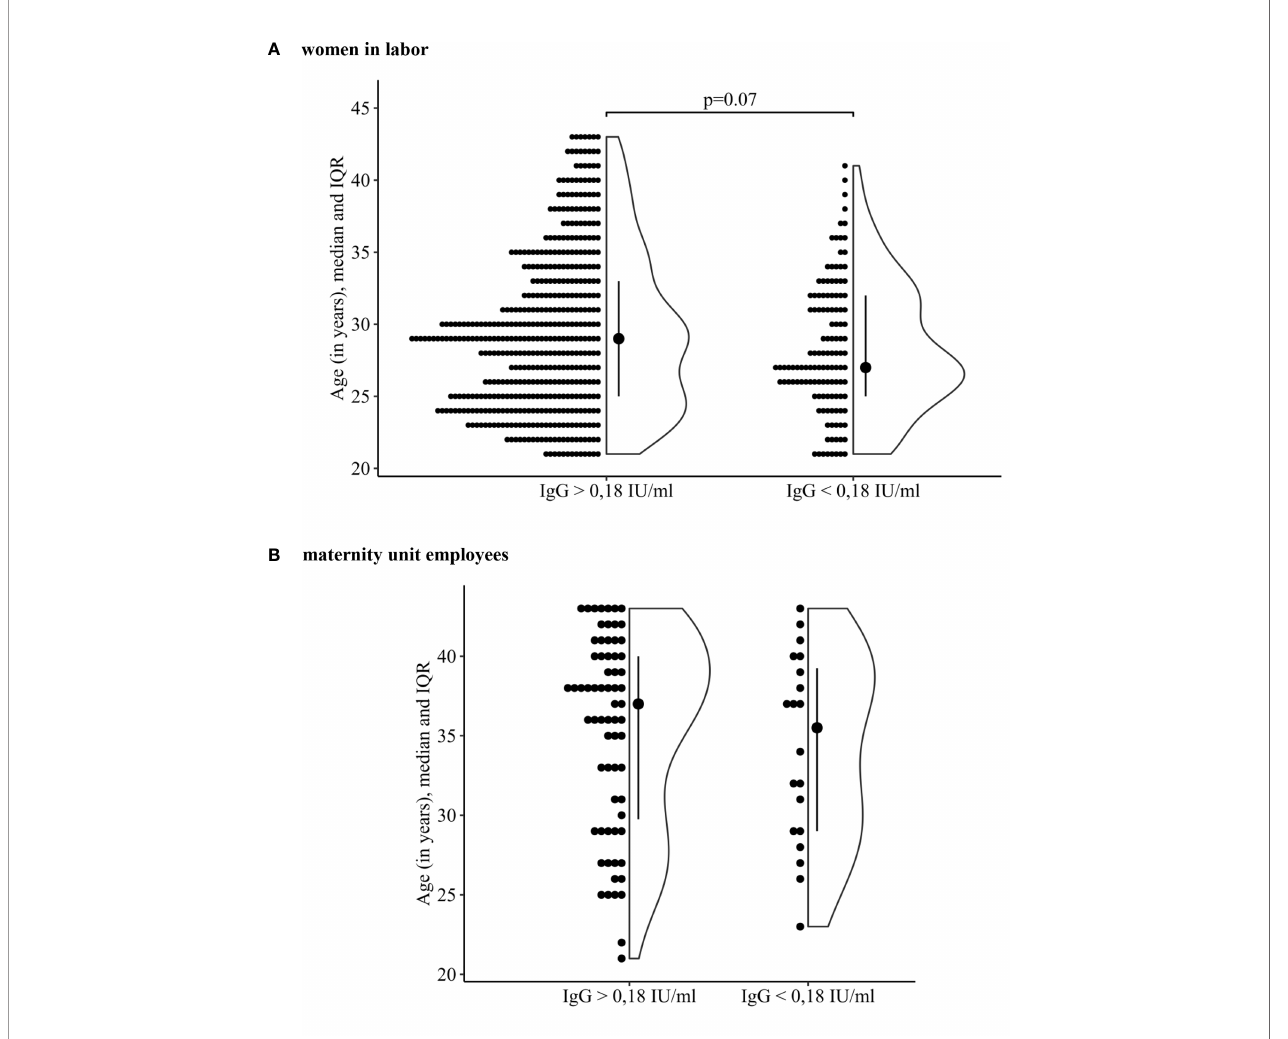
FIGURE 1 | Comparison of the age of women who are seronegative and seropositive to the measles virus. (A) women in labor. (B) maternity unit